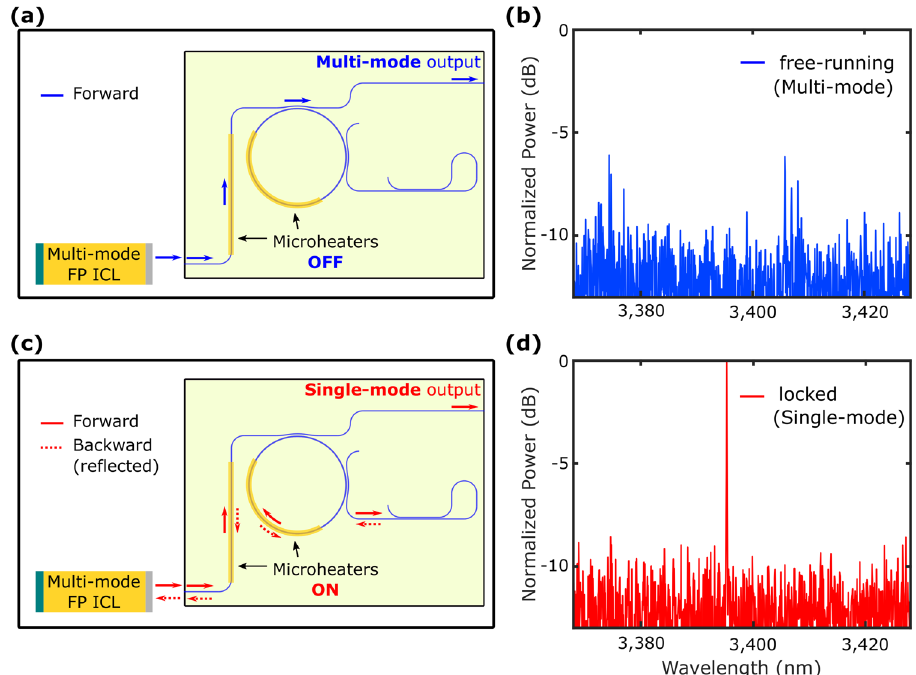
Fig. 4 Self-injection locking of a Fabry – Perot (FP) interband cascade laser (ICL) diode by a microresonator with integrated heaters. a Schematic of the laser setup where microheaters are turned off, and the ring is off-resonance. b Optical spectrum of the free-running state laser with multi-mode output. c Schematic of the laser setup where microheaters are turned on, and the ring is on-resonance. d Optical spectrum of the single-mode locked-state laser. The power measured at the output facet of the chip through an aspheric lens is 0.4 mW near the wavelength of 3.4 μ m.